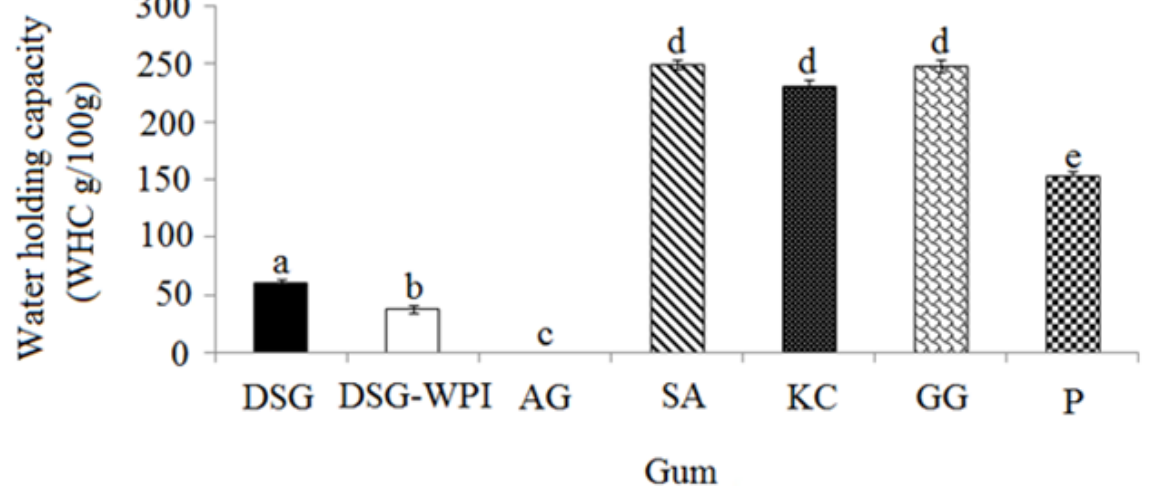
Figure 1. Water holding capacity (WHC) of the non-conjugated durian seed gum (DSG) and conjugated durian seed gum (DSG-WPI) as compared to the target commercial gums ( i.e. , Arabic gum (AG), sodium alginate (SA), kappa carrageenan (KC), guar gum (GG), and pectin (P); a – e : significant different at p <